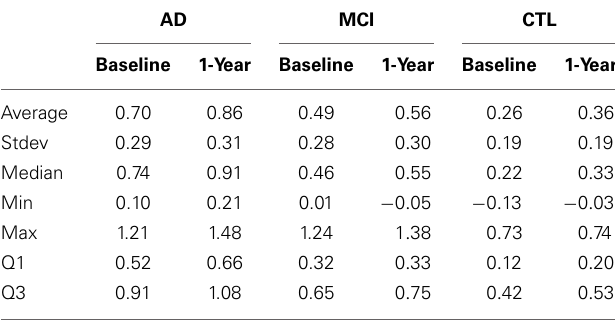
Table 4 | MRI index computed for the longitudinal